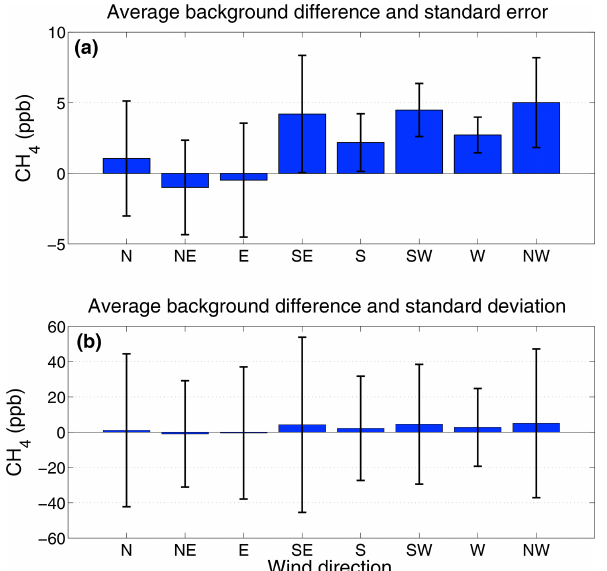
Figure 6. Bootstrap simulation of two times the standard error in Indianapolis CH 4 background mole fraction differences (between criteria 2 and 1) as a function of sample size and wind direction (see text for details). Thresholds for each of the wind directions indicate a random error threshold needed for the background uncertainty to be within 50% of Indianapolis CH 4 enhancement of